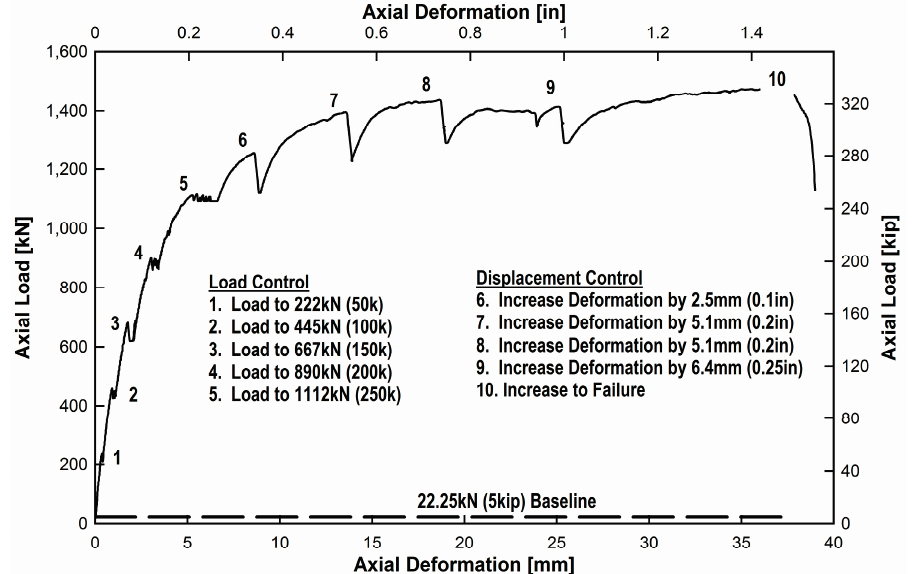
Figure 14. Loading protocol for axial capacity